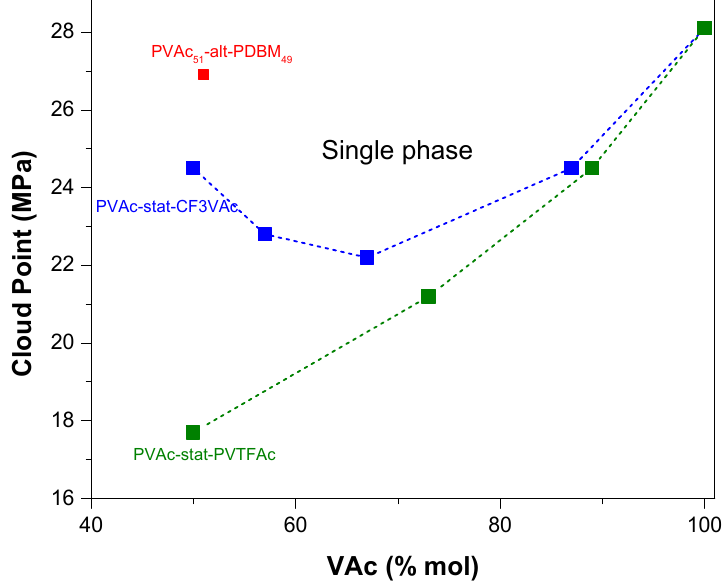
Vac), P(VAc- stat -PVTFAc), 3